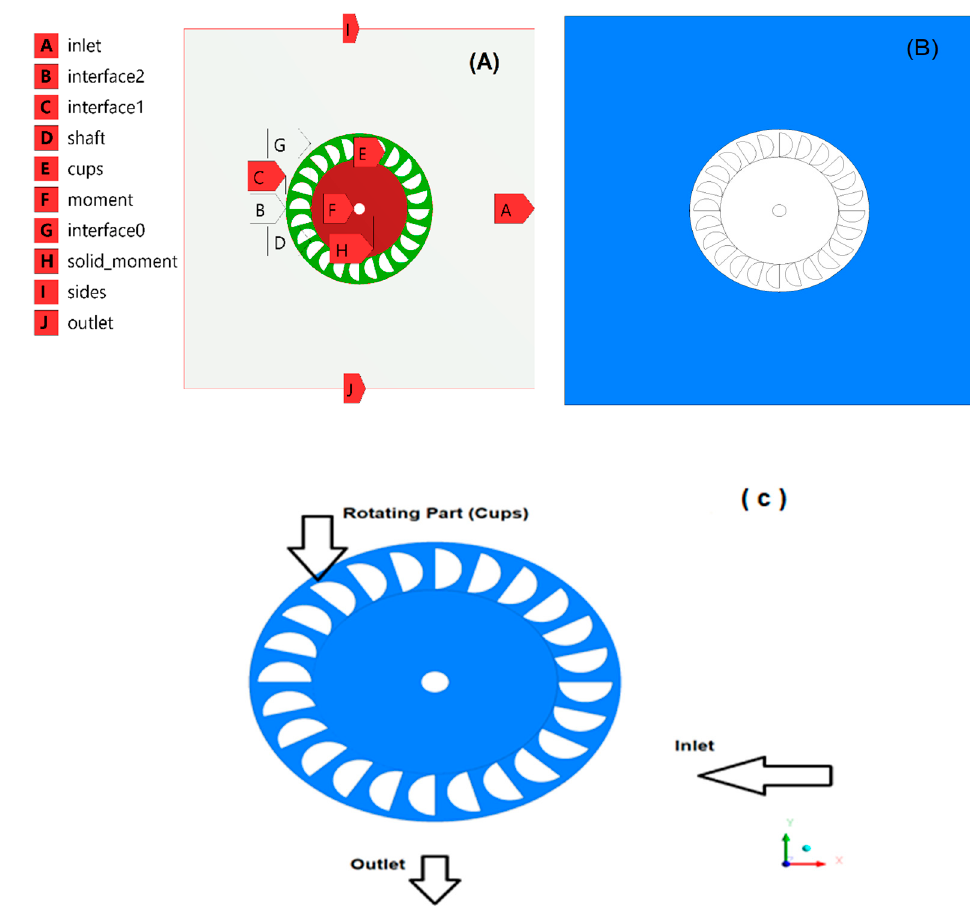
Figure 2. Pelton turbine geometry.